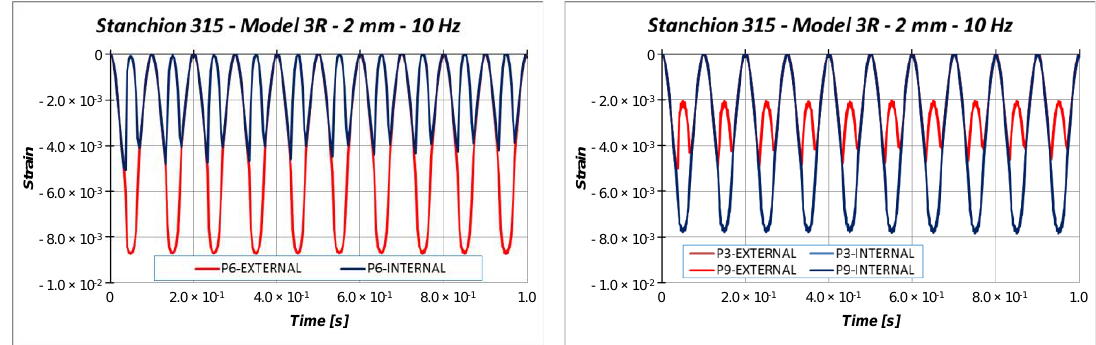
Figure 22. Strain: 2.0 mm applied displacement.